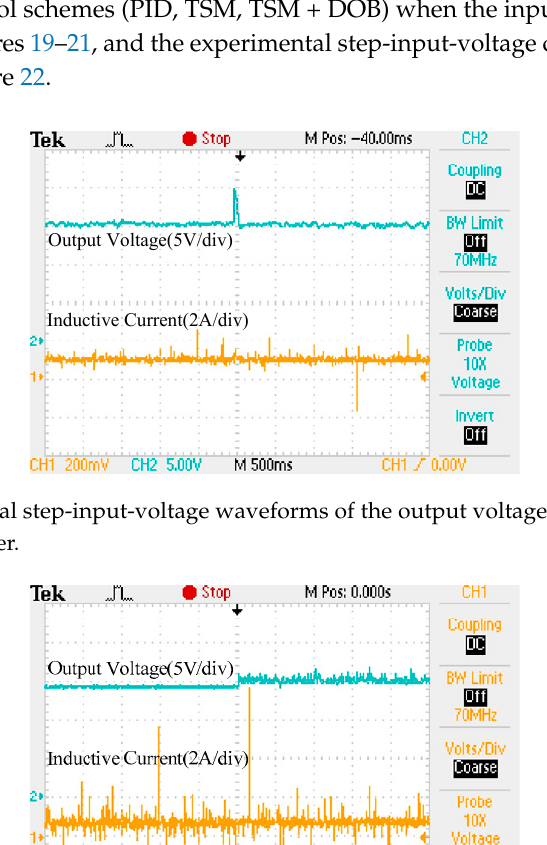
Figure 21. Experimental step ‐ input ‐ voltage waveforms of the output voltage and inductive current under the TSM + DOB controller. 3.5